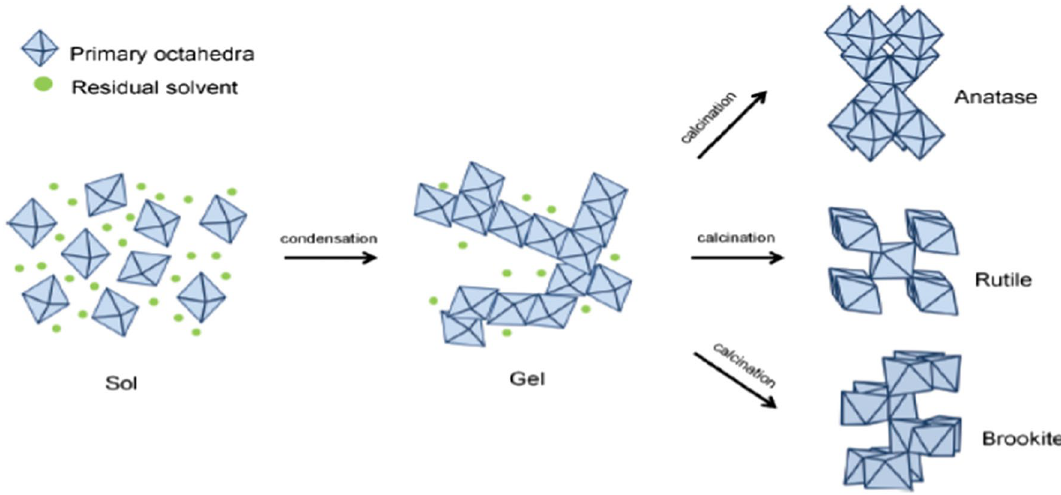
Fig. 3 Steps for the synthesis of crystalline anatase, rutile, and brookite TiO